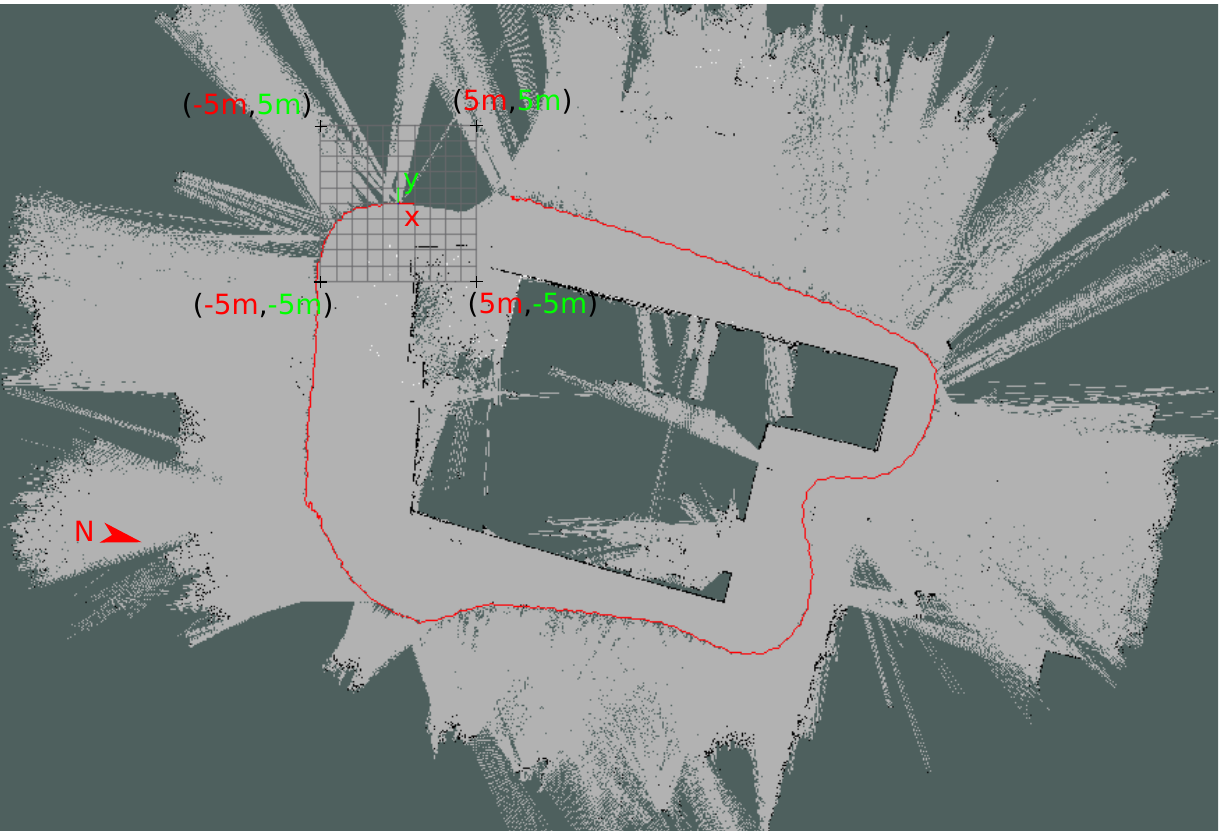
Figure 18. 2D map of the outdoor dataset created by HectorSLAM in the local coordinate system. Inaccuracies arose when the SICK scanner covered open terrain. The superimposed grid has a size of 10 × 10 m 2 , and the red line denotes the